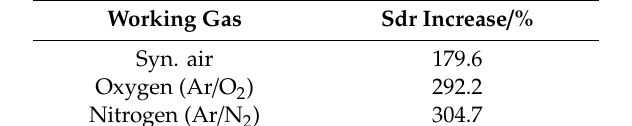
Table 2. Percentual developed interfacial area ratio (Sdr) increase of PP60 before and after plasma treatment with different working gases.